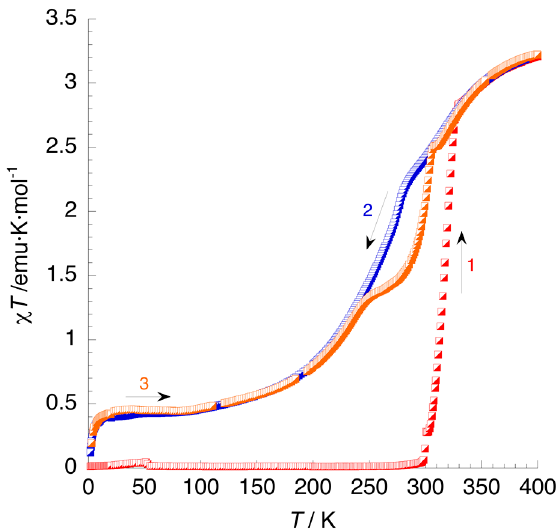
Figure 6. Thermal variation of χ T of 1 · 4H 2 O. Curve 1: first heating process (the bump observed around 50 K is due to the presence of oxygen). Curves 2 and 3: first cooling and second heating processes, respectively.